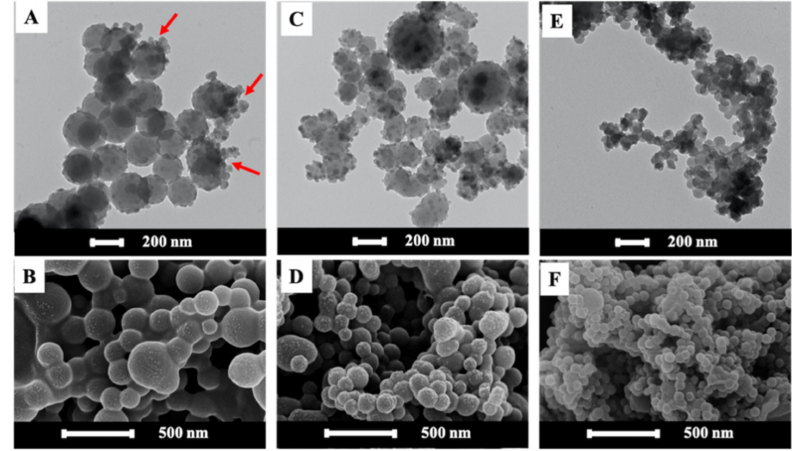
Figure 2. TEM and SEM images of spherical ZPPs prepared from P(St/AA) with various SDS concentrations of 0.5 (below CMC) ( A , B ), 1.5 (at CMC) ( C , D ), and 3.0% (above CMC) ( E , F